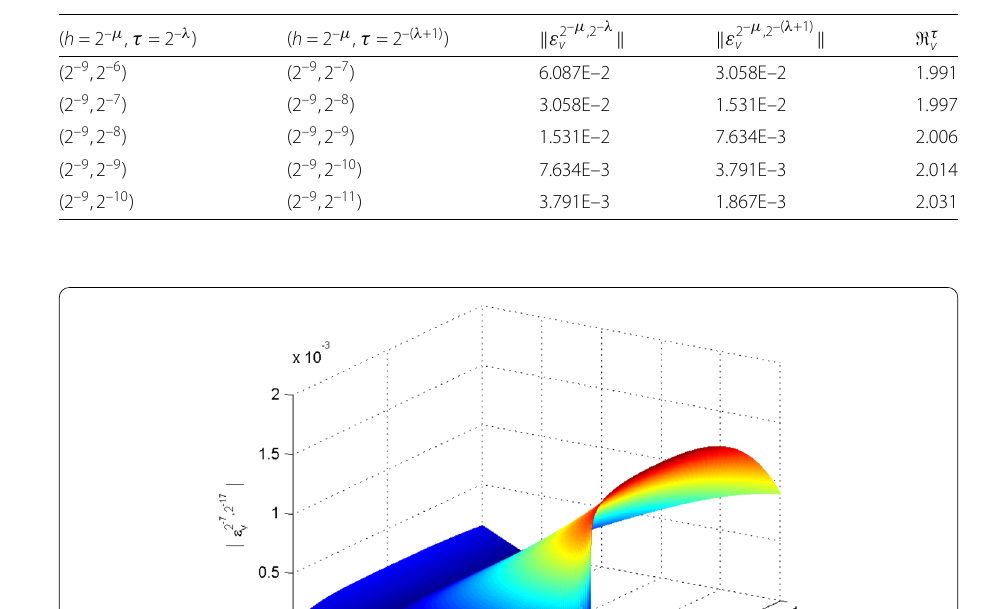
Figure 1 The error function | ε